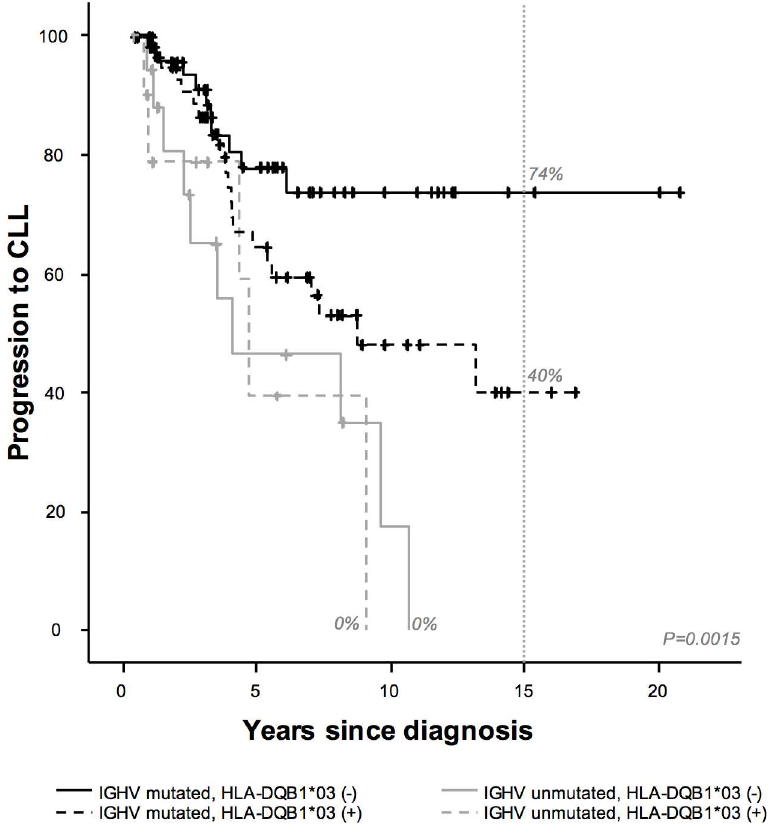
Fig 1. Kaplan–Meier analysis of 15-yearhiMBL progression to CLL by HLA-DQB1 * 03and IGHV status. IGHV mutated and unmutatedstatus are depicted by black and gray lines, respectively. The presence and absenceof HLA-DQB1 * 03are shown by dashed and continuous lines, respectively.The vertical dashed line indicates15-year follow-up.